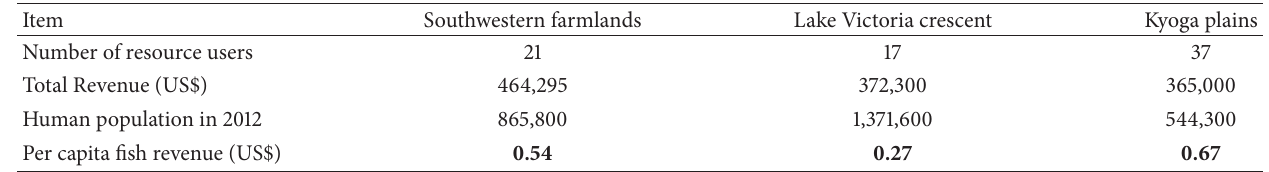
Table 3: Per capita fish availability among the local communities in the wetlands areas of Uganda. Item